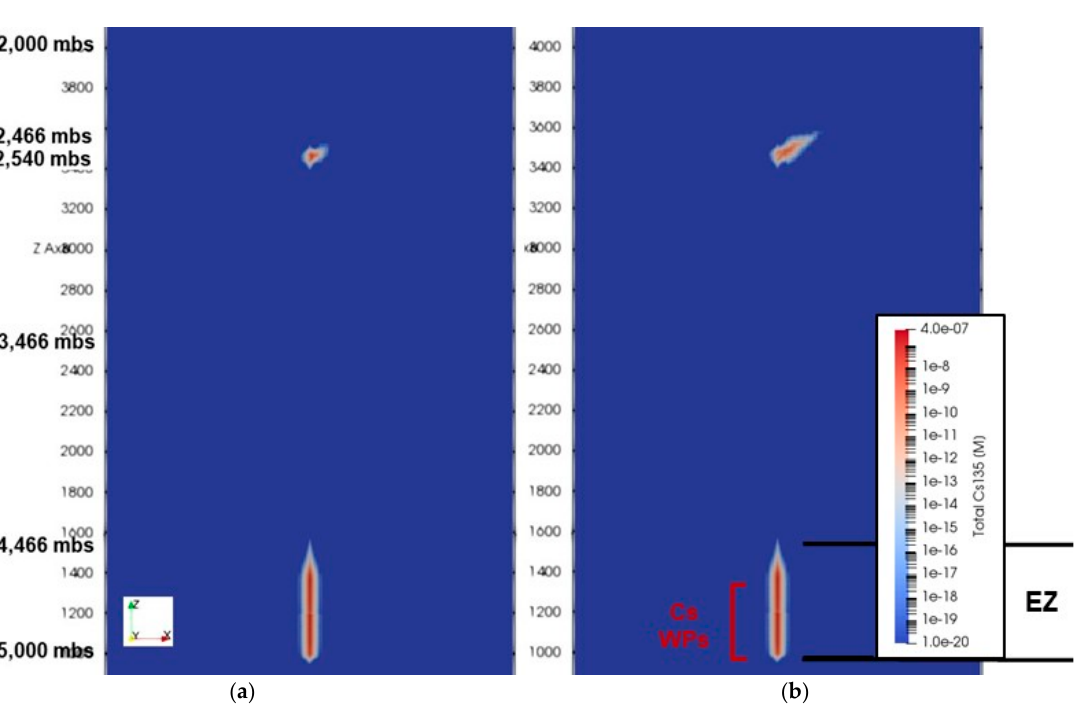
Figure 8. Dissolved concentration of 135 Cs at 10,000,000 years for the stuck package scenario. Regional gradient = ( a ) 0 m/m; and ( b ) 0.0001 m/m. Source: Freeze et al. [5].